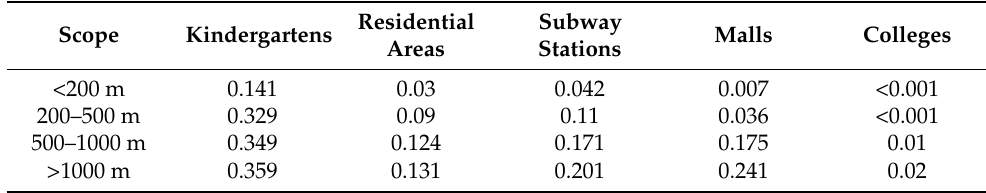
Table 5. Probability of casualties for each scenario within the range of different liquid ammonia